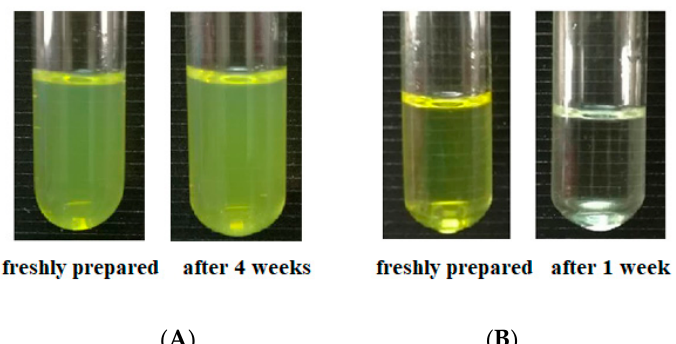
Figure 7. ABTS •+ radical scavenging capacity of the model beverage incorporated with free Cur, blank zein ‐ caseinate ‐ pectin particles or Cur ‐ loaded zein ‐ caseinate ‐ pectin particles during storage at 4 °C. Values marked with different letters indicated a significant difference between different groups for the same storage time period ( p < 0.05). Error bars represent standard deviations from three replicates.